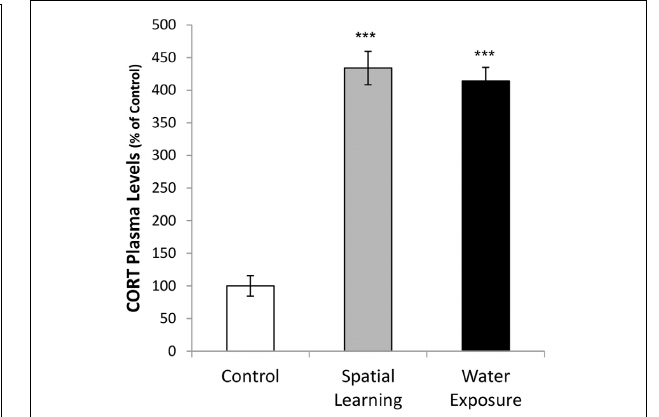
FIGURE 3 | Activation of hormonal stress response by water maze experience. Corticosterone (CORT) plasma concentrations were increased after both, water maze exposure alone and with an invisible platform enabling spatial learning, compared to handeled Controls (CORT concentration Control = 386 ± 60ng/ml). Values are mean ± s.e.m. ∗∗∗ Significant difference from Control with p < 0 .